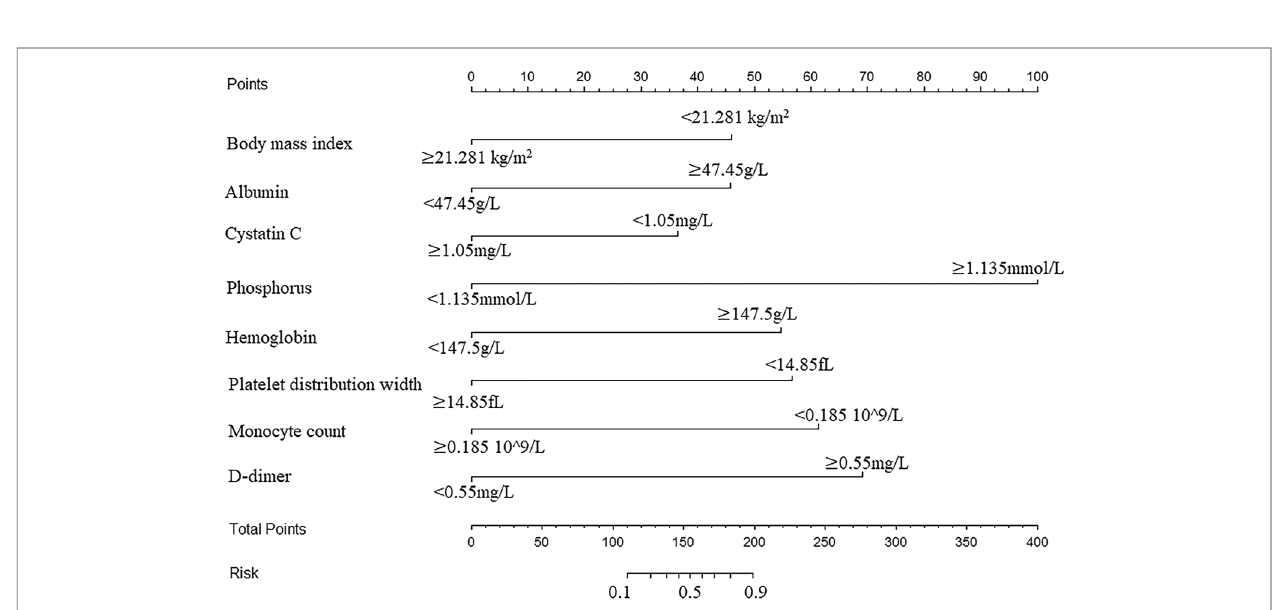
FIGURE 2 | Nomogram to predict the pathologic complete response rate of breast cancer patients after neoadjuvant chemotherapy based on clinical characteristics and hematological